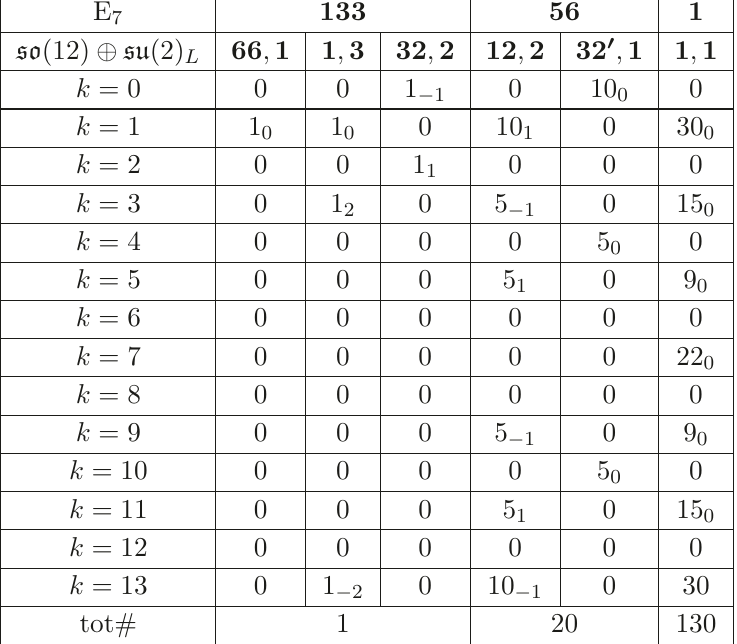
Table 3 . Summary of massless spectrum for the E 7